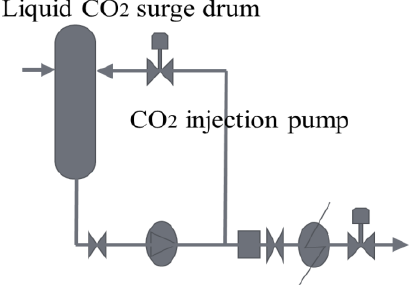
Figure 6. Liquefaction process of CO 2 .